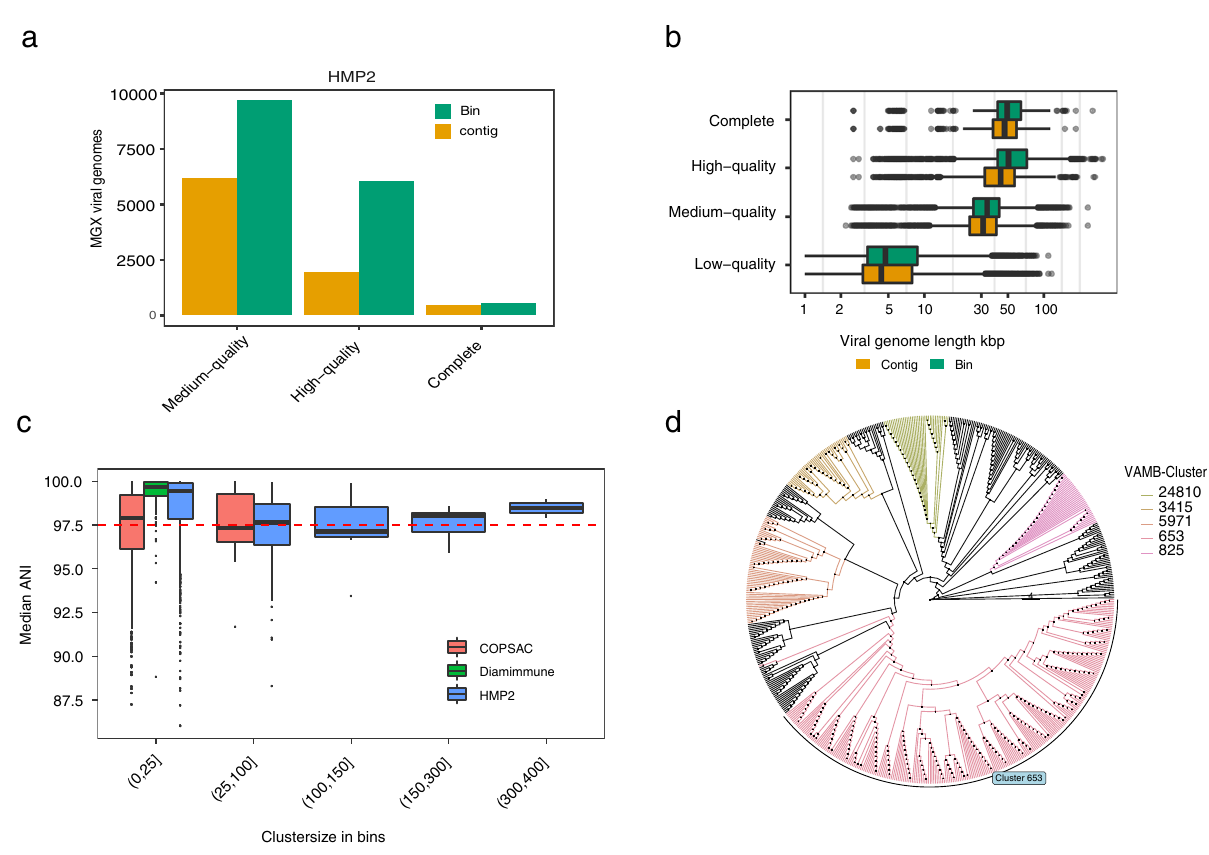
Fig. 3 Reconstructing the virome of a human gut metagenomics cohort. a The number of viral genomes with three different levels of completeness in HMP2, evaluated as either single-contigs or viral bins from bulk metagenomes. Evaluation of genome completeness was determined using CheckV here shown for medium-quality ≥ 50% (MQ), high-quality ≥ 90% (HQ), Complete = closed genomes based on direct terminal repeats or inverted terminal repeats. b The sequence length distribution in kbp of viral genomes at four different levels of completeness in HMP2, evaluated as either single-contigs ( n = 215,009) or viral bins ( n = 138,367) from bulk metagenomes. Shown for low-quality (LQ) <50%, MQ, HQ and Complete. c Median ANI based on pairwise ANI genome measurements between bins within the same VAMB cluster. Median ANI is consistently above 97.5 in small VAMB clusters with 0 – 25 bins and in larger VAMB clusters with 300 – 400 bins. d Cladogram of an unrooted phylogenetic tree with crAss-like bins based on the large terminase subunit protein (TerL). Five different VAMB clusters have been coloured and illustrate high monophyletic relationships. The phylogenetic tree was constructed using IQtree using the substitution model VT + F + G4. ANI average nucleotide identity %, DTR direct terminal repeats, ITR inverted terminal repeats, Kbp kilobase